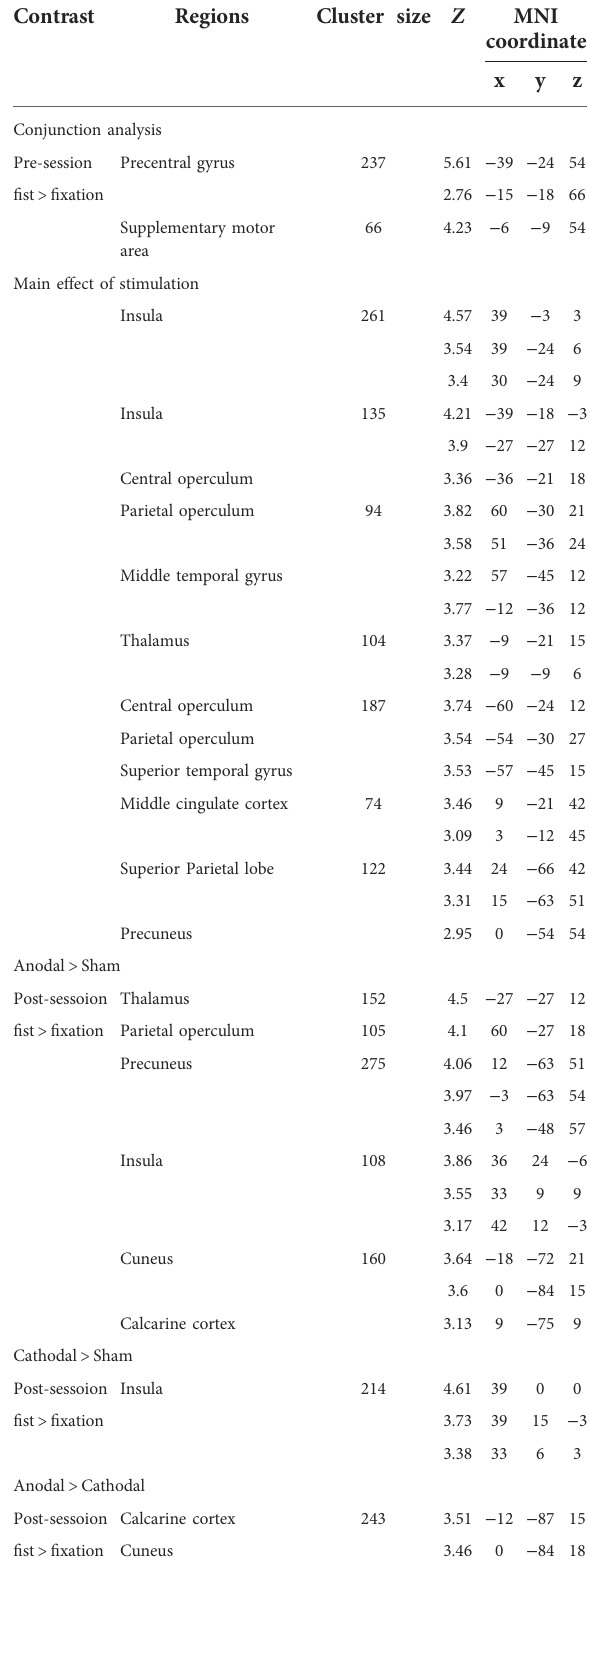
TABLE 1 Results of the whole-brain GLM